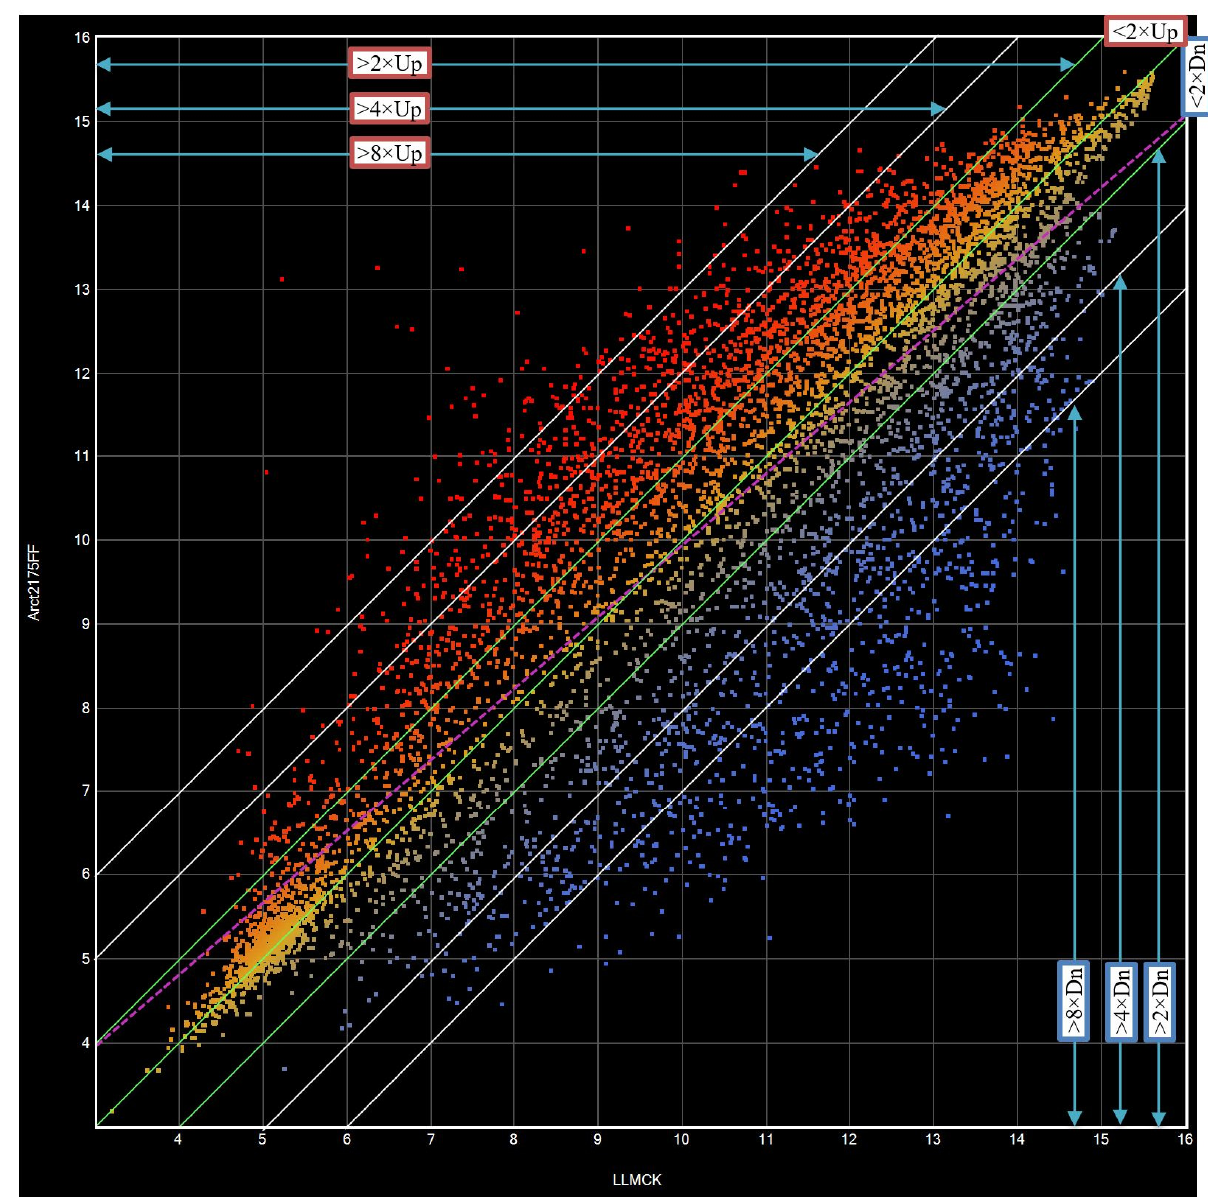
Figure 1. Analysis of microarray data and comparison of 6688 gene expression levels between susceptible (LLMCK) and permethrin-selected (Arct2175FF) tarnished plant bugs using ArrayStar software. Scatter-plot comparison of 6688 gene expression levels between LLMCK and Arct2175FF. The mini squares of the scatter plot in the upper left corner represented up-regulated genes, and the squares in low right corner represented down-regulated genes. Squares above line 2 × Up and below line 2 × Dn represent up- and down-regulated genes by 2-fold; Squares above line 4 × Up and below line 4 × Dn represent up- and down-regulated genes by 4-fold; Squares above line 8 × Up and below line 8 × Dn represent up- and down-regulated genes by 8-fold.